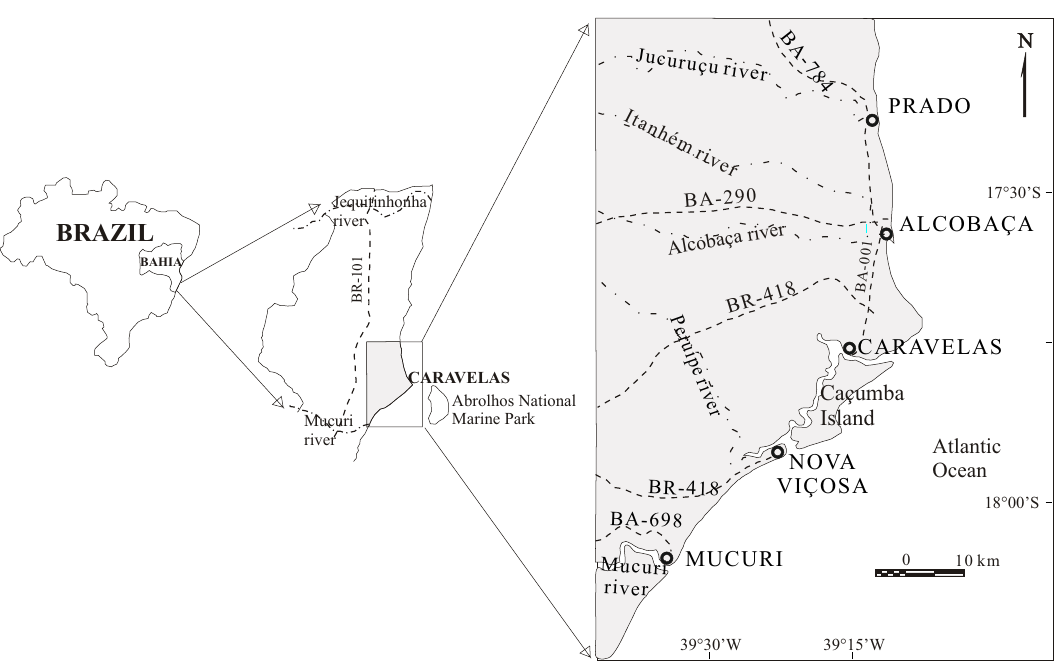
Fig. 1 – Location of the study